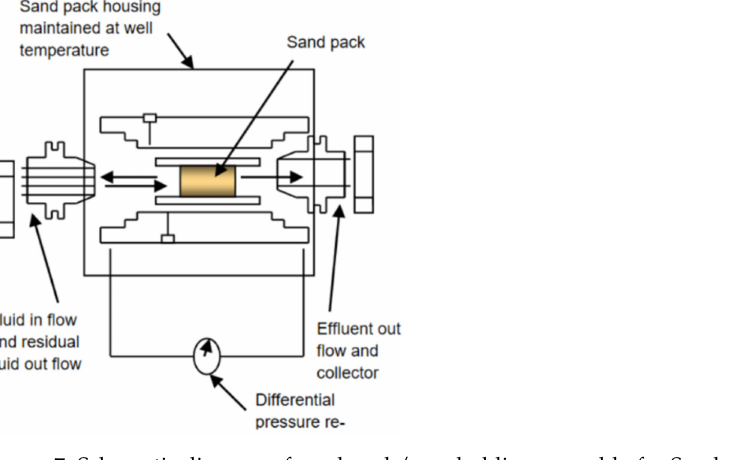
Figure 7. Schematic diagram of sand pack/core holding assembly for Sand pack test. Extracted and modified from